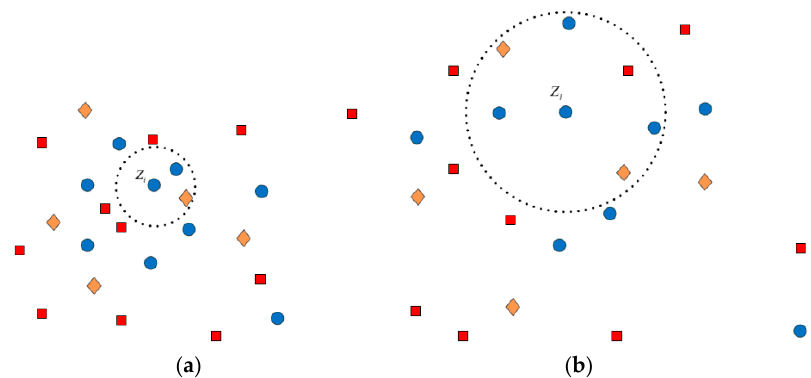
Figure 4. Neighborhood estimation of Z i : ( a ) small neighborhood size for aggregated samples; ( b ) large neighborhood size for dispersed samples.